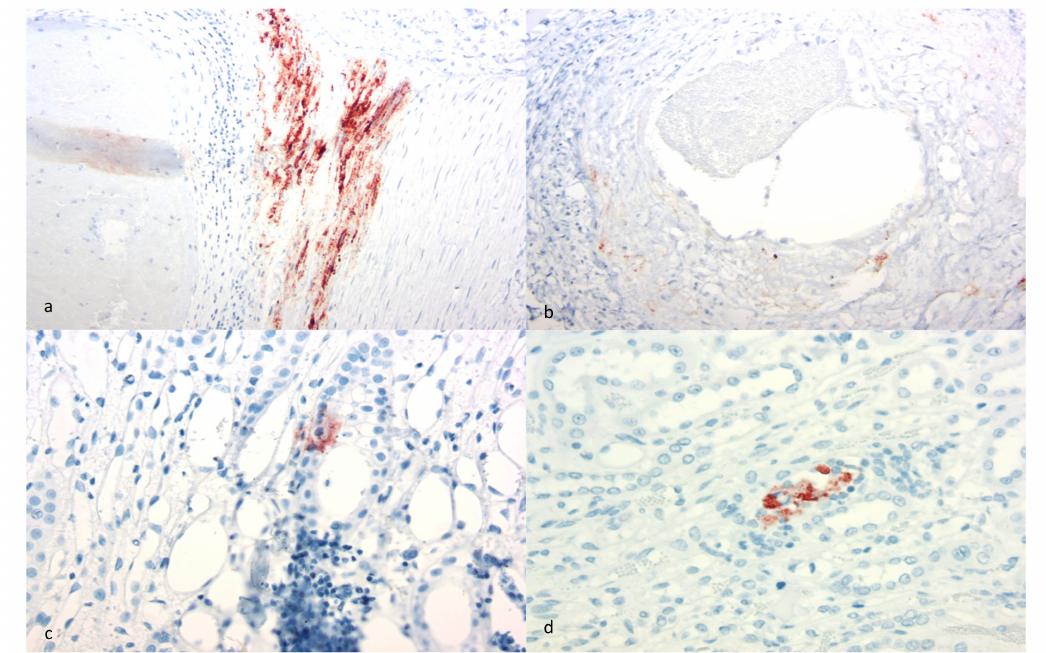
Figure 4. Immunohistological features of CAEV-associated cardiac and renal lesions (SRLV IHC). ( a ) Abundant CAEV antigen is present (brown staining granules) within the arterial tunica media (heart, goat A). ( b ) Moderate CAEV antigen is present within the arterial tunica media (kidney, goat A). ( c ) Focal CAEV antigen deposition is present within the tubular epithelium of the renal medulla (kidney, goat C). ( d ) Focal CAEV antigen is present within the tubular epithelium in the renal medulla (kidney, goat